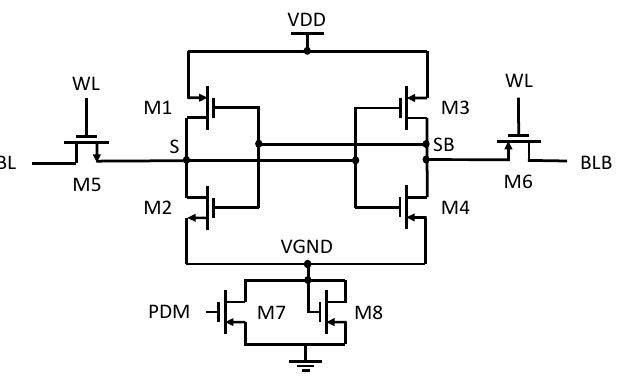
Figure 1. 6T-SRAM cell with back-bias circuit.